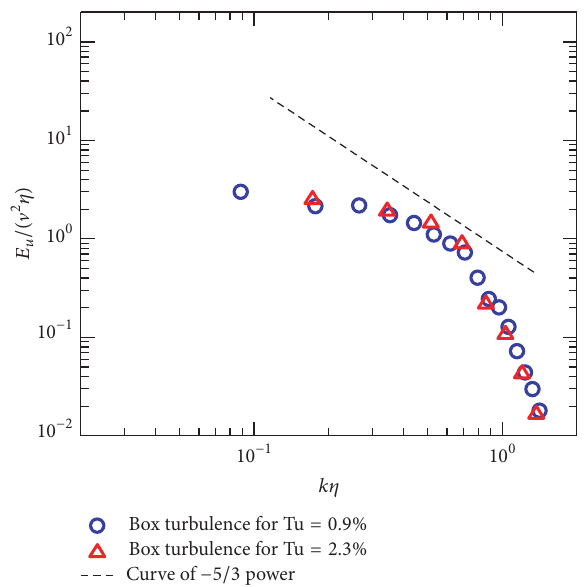
Figure 5: Energy spectra of homogeneous box